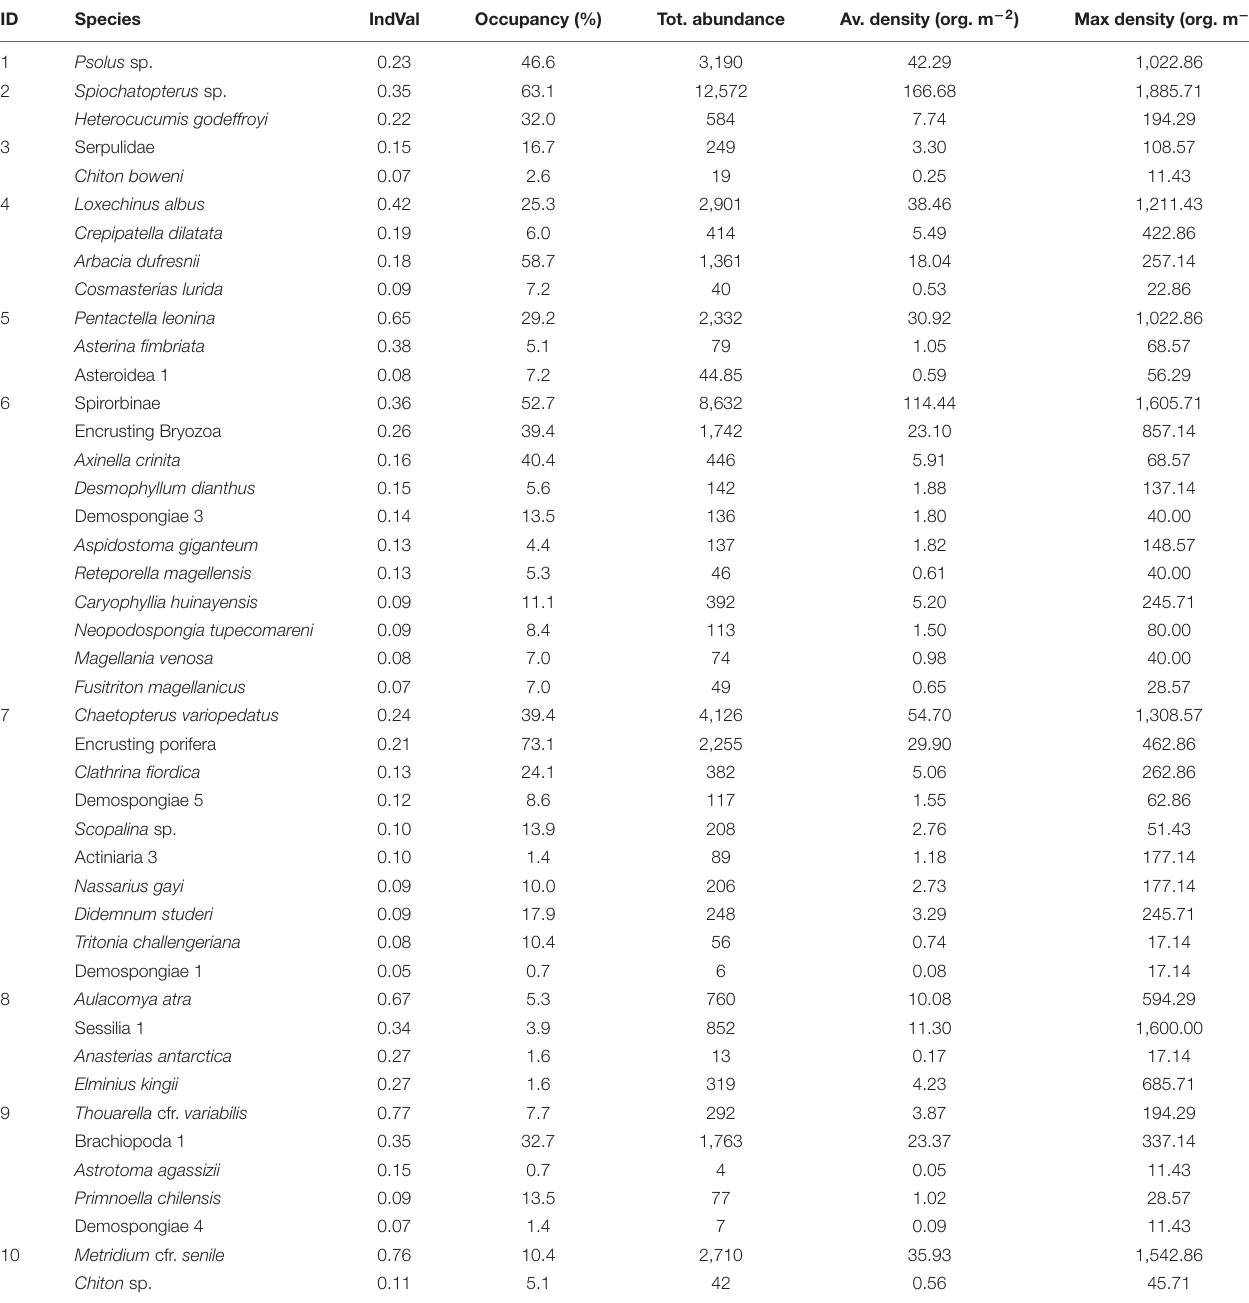
TABLE 4 | Summary of the main species characterizing the 10 megabenthic communities identified in this study, with ecological